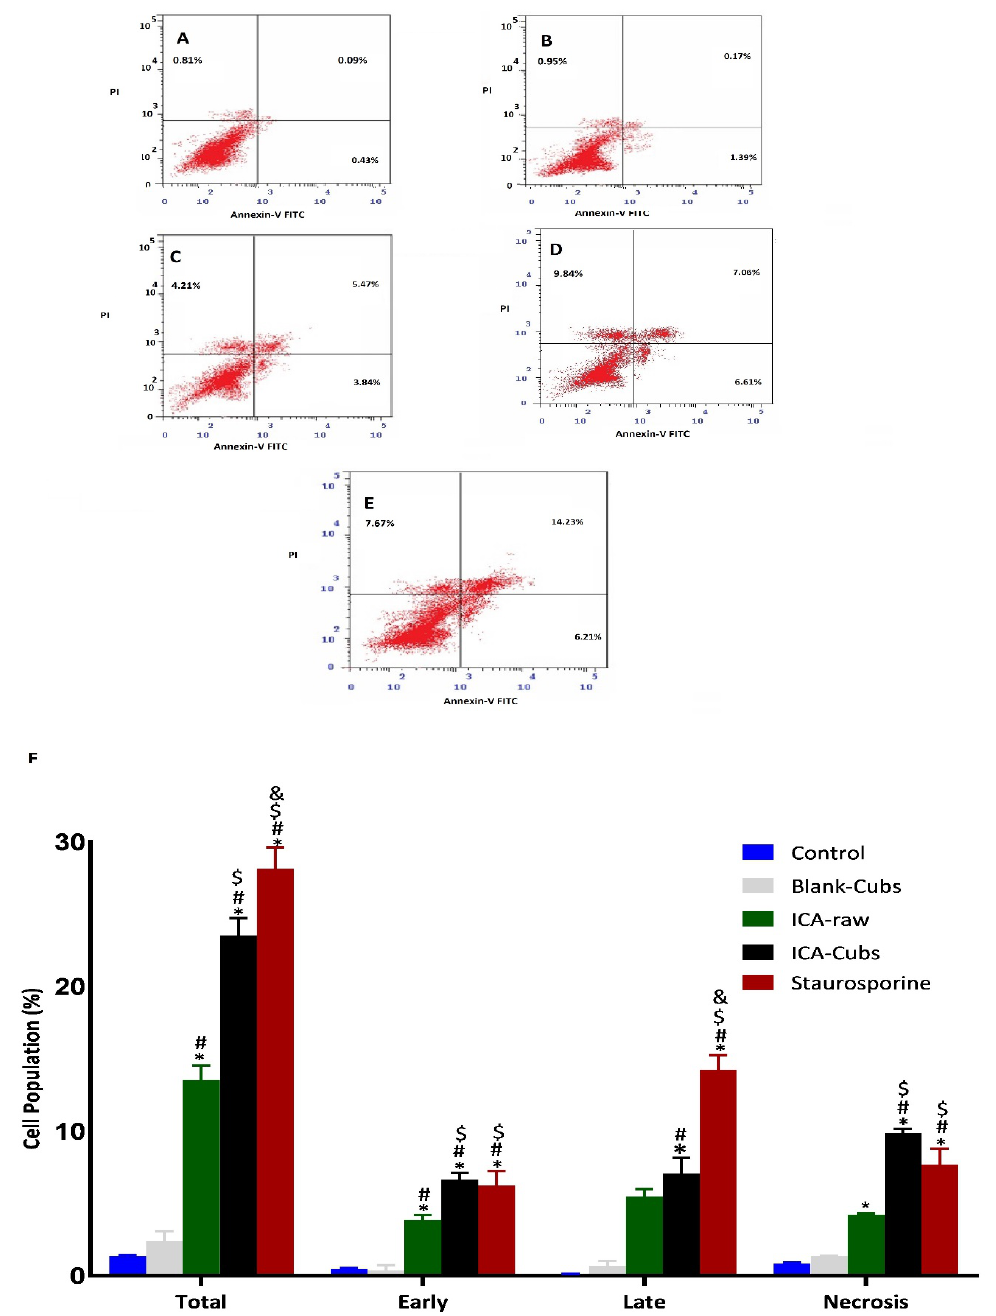
Figure 10. Apoptotic potential using flow cytometric analysis following Annexin V staining of the SKOV-3 cell line without treatments ( A ) and after treatment with ( B ) blank-Cubs, ( C ) ICA-raw, ( D ) ICA-Cubs and with ( E ) staurosporine. Data are expressed in ( F ) as the mean ± SD (n = 4 runs). Representation of SKOV-3 cell death following apoptotic and necrotic assay by cytometric analysis after annexin V staining. * represents a significant difference when compared with untreated cells (control) ( p < 0.05), whereas # represents a significant difference when compared with the blank-Cubs ( p < 0.05), $ represents a significant difference when compared with the ICA-raw ( p < 0.05), and & represents a significant difference when compared with the ICA-Cubs ( p < 0.05).